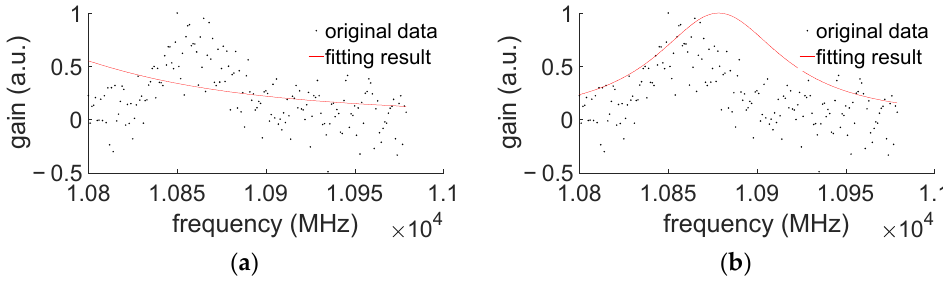
Figure 14. Curve fitting, ( a ) Error fitting, and ( b ) Inappropriate fitting.